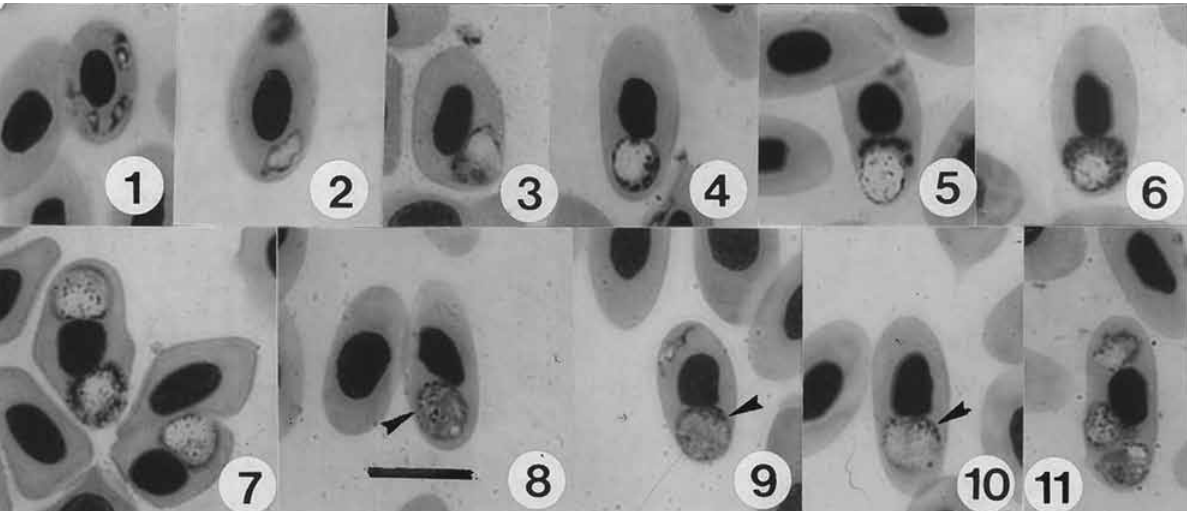
Figs 1-11. – Plasmodium carmelinoi n. sp. in the teiid lizard Ameiva ameiva . 1. Four young irregularly shaped trophozoites in the same erythrocyte; 2. Growing uninucleate trophozoite, of irregular shape and assuming the polar position of development in the host cell: note the large vacuole and peripheral band of cytoplasm; 3-6. Progressive nuclear division of the growing schizont to form from 8-12 merozoites: the large vacuole now contains most of the pigment granules; 7. one erythrocyte containing a mature microgametocyte (above) and a mature schizont (below), and another with a single microgametocyte; 8. a nearly mature macrogametocyte; 9. Mature macrogametocyte and a growing trophozoite in the same erythrocyte; 10. Mature microgametocyte: note the smaller vacuole of the gametocytes (arrow heads) containing most of the pigment granules; 11. Erythrocyte containing two developing gametocytes (below) and a growing schizont (above). Bar = 10